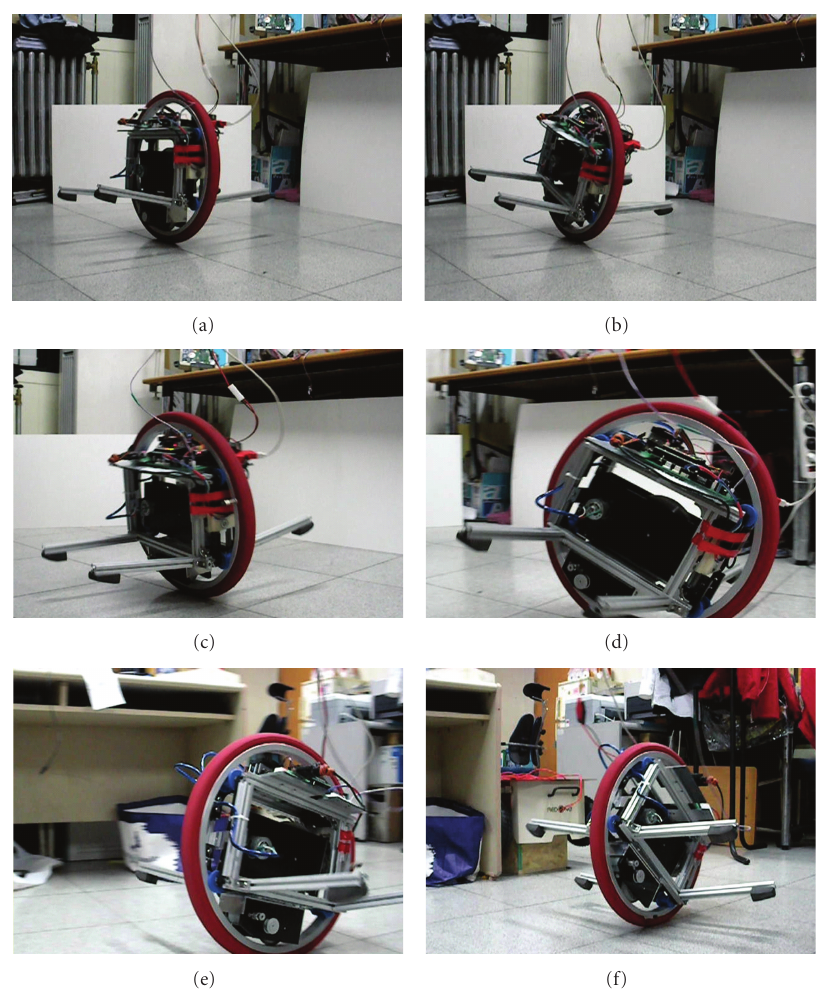
Figure 18: PD control: line following